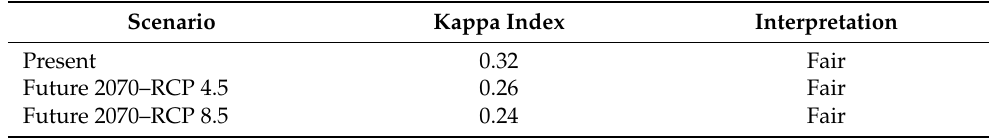
Table 7. Comparison of the MaxEnt and species ecological envelopes methodologies using Kappa